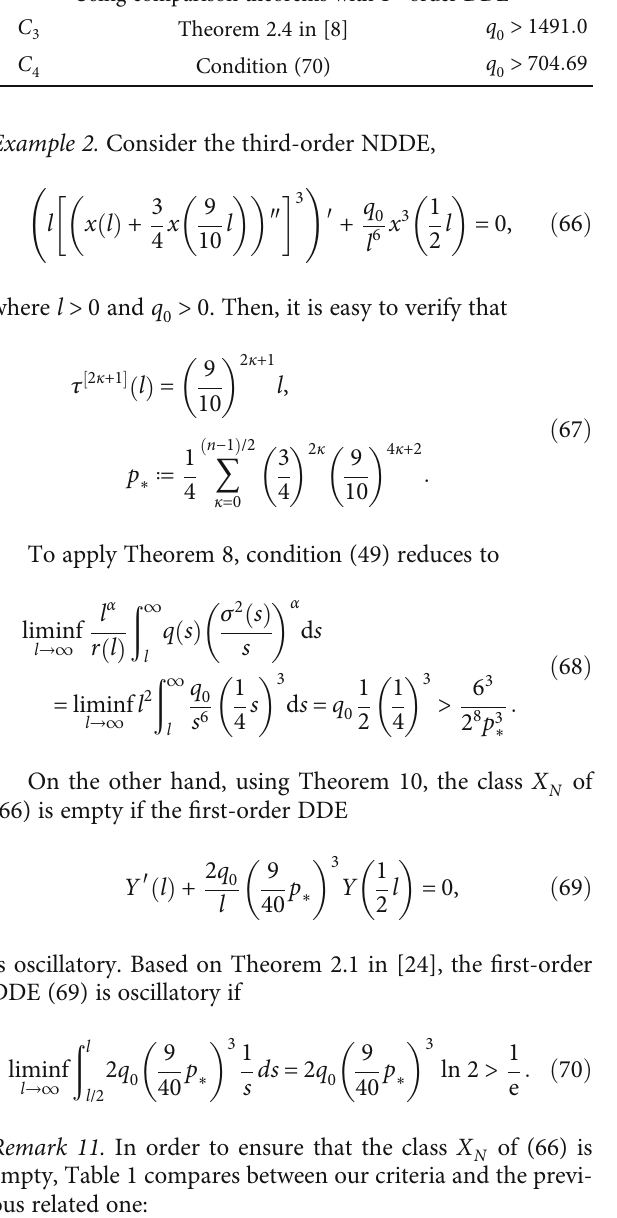
Table 1: Criteria that ensure that X